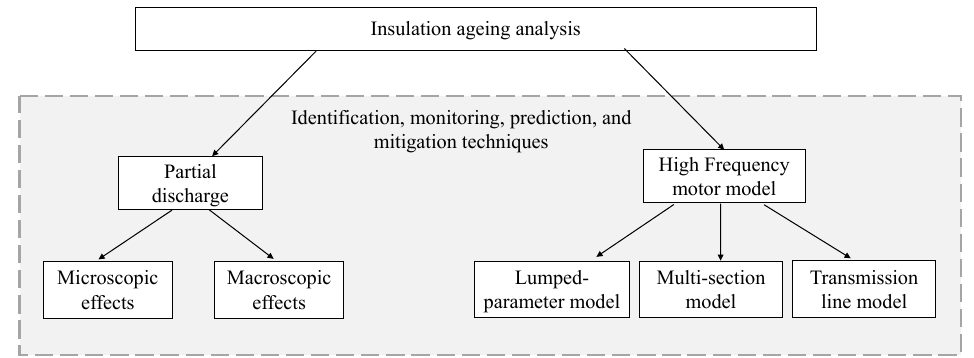
Figure 1. Ageing insulation’s studies presented in this